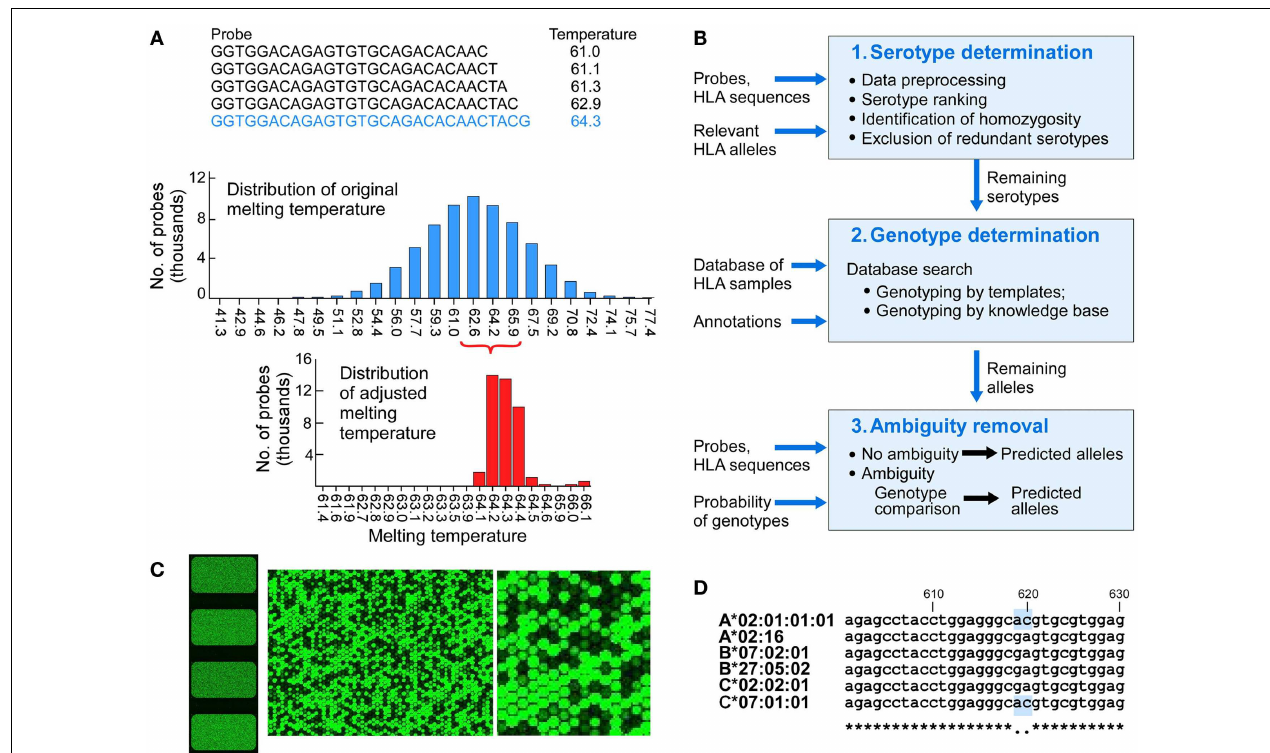
showing signals on a portion of one array). (C) Analytical workflow used templates of known samples or a theoretically derived knowledgebase.The three main steps include serotypes determination, genotypes determination, and ambiguity removal.The input includes probes, probe signals, and HLA sequences of target alleles.The output includes genotypes assigned by template matching (see Figure 3 for details) or genotype matching with ambiguity removal (described in the main text). (D) Sample 4 ( Table 3 ) was HLA-A*02:01/A*02:01, B*07:02/B*27:05, C*02:02/C*07:01